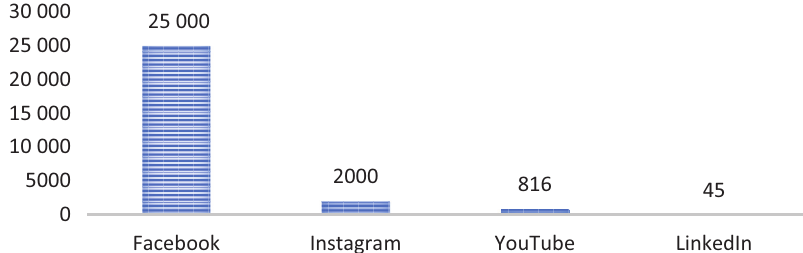
Figure 1. Numbers of followers on social networks in National Kaunas Drama Theatre, Lithuania. April, 2021 (source: created by